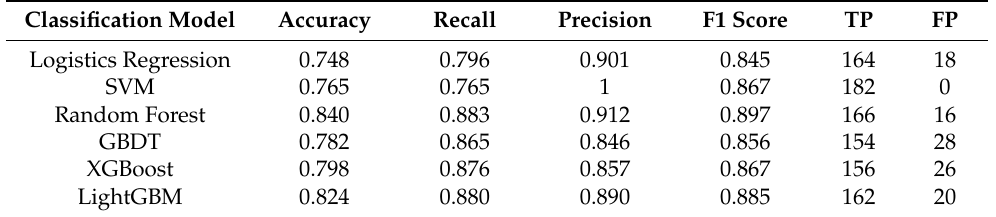
Table 6. Evaluation results of each classification model.